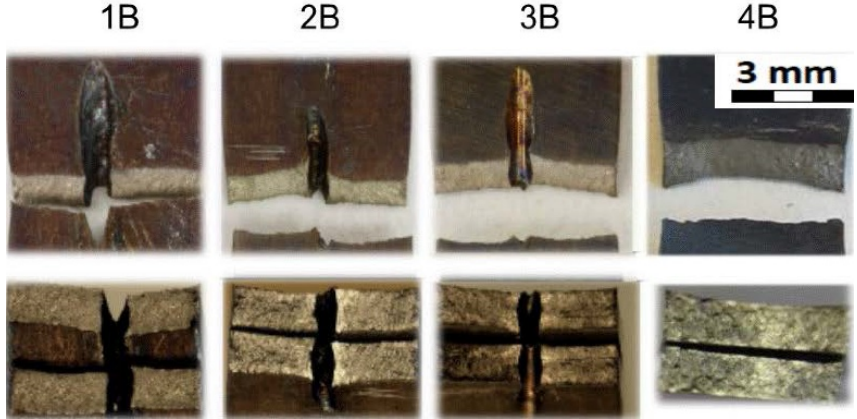
Figure 16. Fracture areas and fracture surfaces of individual sample groups—material thickness Table 10. Average values of mechanical properties—Inconel 718; material thickness 1.0 mm; tests 1.0 mm; tests at elevated at elevated temperature.